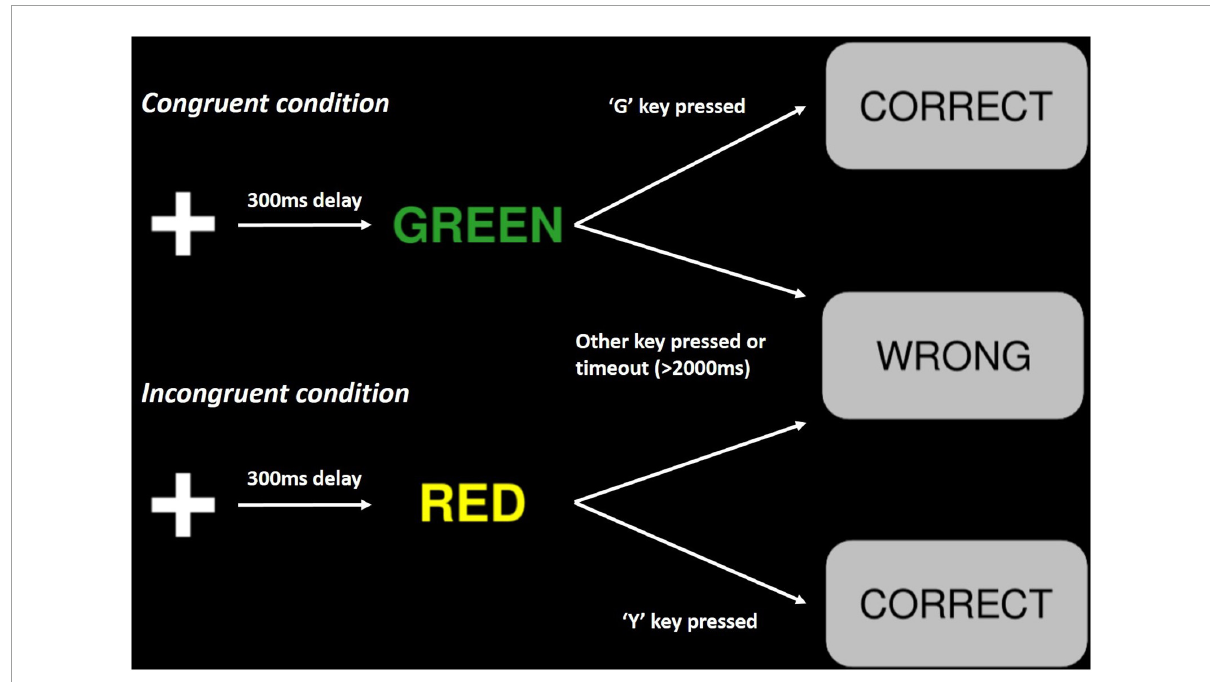
FIGURE2 Schematic representation of the experimental paradigm in the PsyToolkit Stroop test. Trials begin with on the onset of a white cross, followed by the presentation of a colour name printed in coloured ink. A grey text box displaying either “CORRECT” or “WRONG” indicates a correct or incorrect response, respectively (Stoet, 2010,